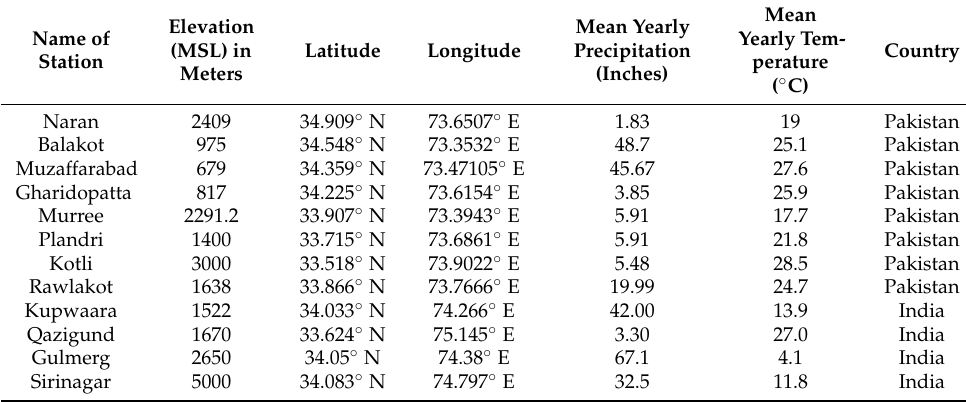
Table 1. Statistics of rainfall stations in the Mangla